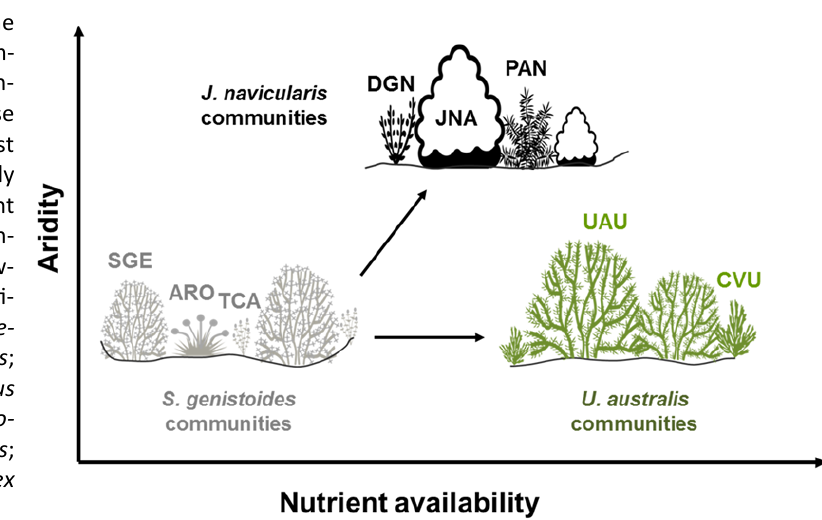
Figure 1. Conceptual model of the xerophytic shrub community dynam- ics on stabilized dunes of the south- western Iberian Peninsula. I propose that scrub dynamics in Alentejo coast and Peninsula of Setúbal are mainly determined by the soil nutrient matter content, driven by succession- al processes, and water stress, follow- ing an aridity gradient. Arrows